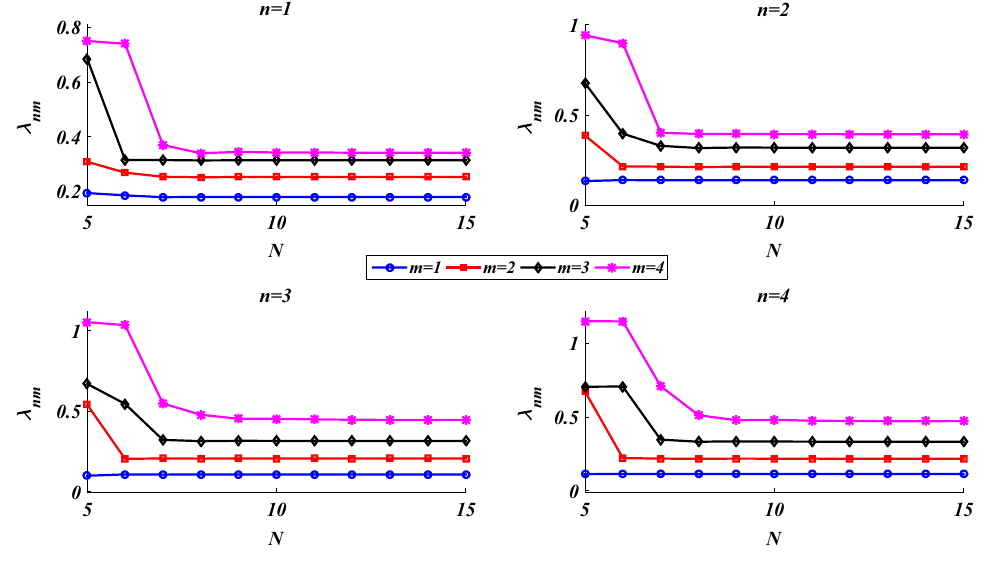
Figure 3. Convergence analysis of the presented